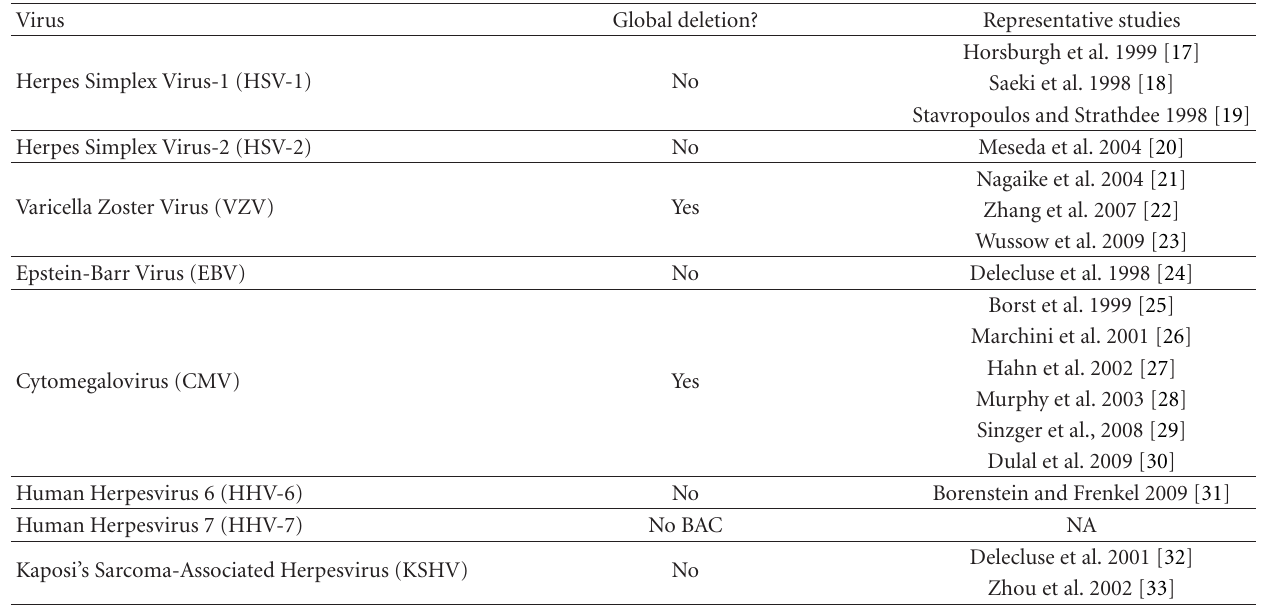
Table 1: BAC-based human herpesvirus studies.